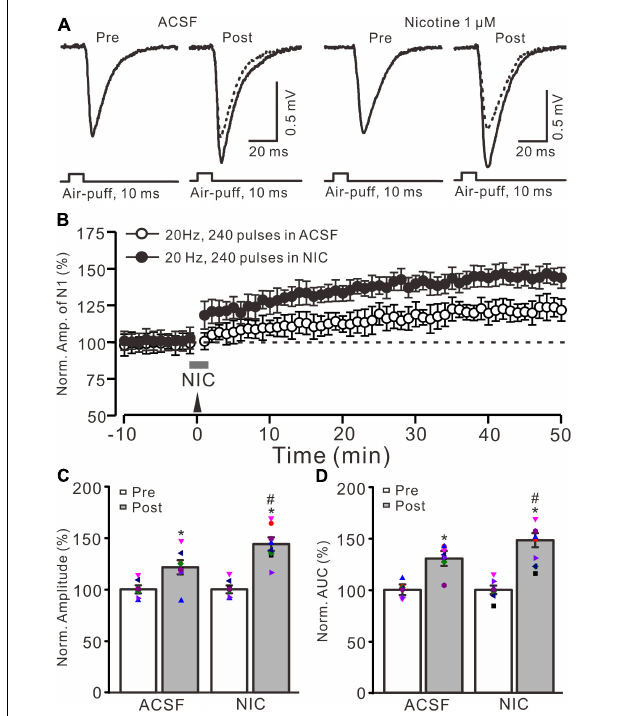
FIGURE 1 | Nicotine enhanced the facial stimulation-induced LTP of MF-GrC synaptic transmission in the mouse cerebellum. (A) Representative extracellular recording traces illustrating facial stimulation (10 ms, 60 psi)-evoked MF-GC synaptic transmission before and after delivery of 20 Hz (240 pulses) stimulation in the absence (ACSF; open circle) and the presence (filled circle) of nicotine (NIC; 1 µ M). (B) Summary of data showing the time course of normalized amplitude of the response before and after delivery of 20 Hz facial stimulation (arrow head) in the absence (ACSF; open circle) and the presence (filled circle) of nicotine (gray bar; NIC; 1 µ M). (C) Bar graph showing the normalized amplitude before (pre) and after (post)